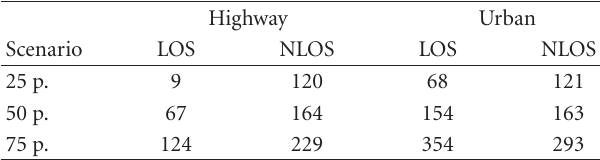
Table 1: Channel scenario RX/TX separation